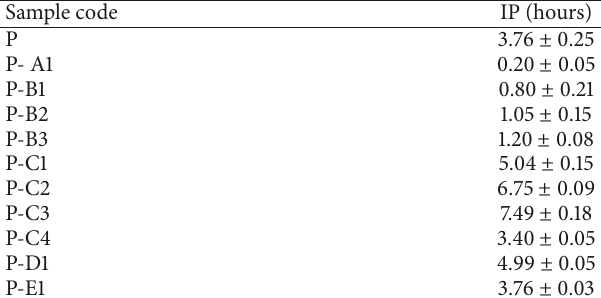
Table 4: Induction period (IP) for pure soybean biodiesel and containing individual additives obtained by Rancimat method. Sample code and concentration values are revealed in Tables